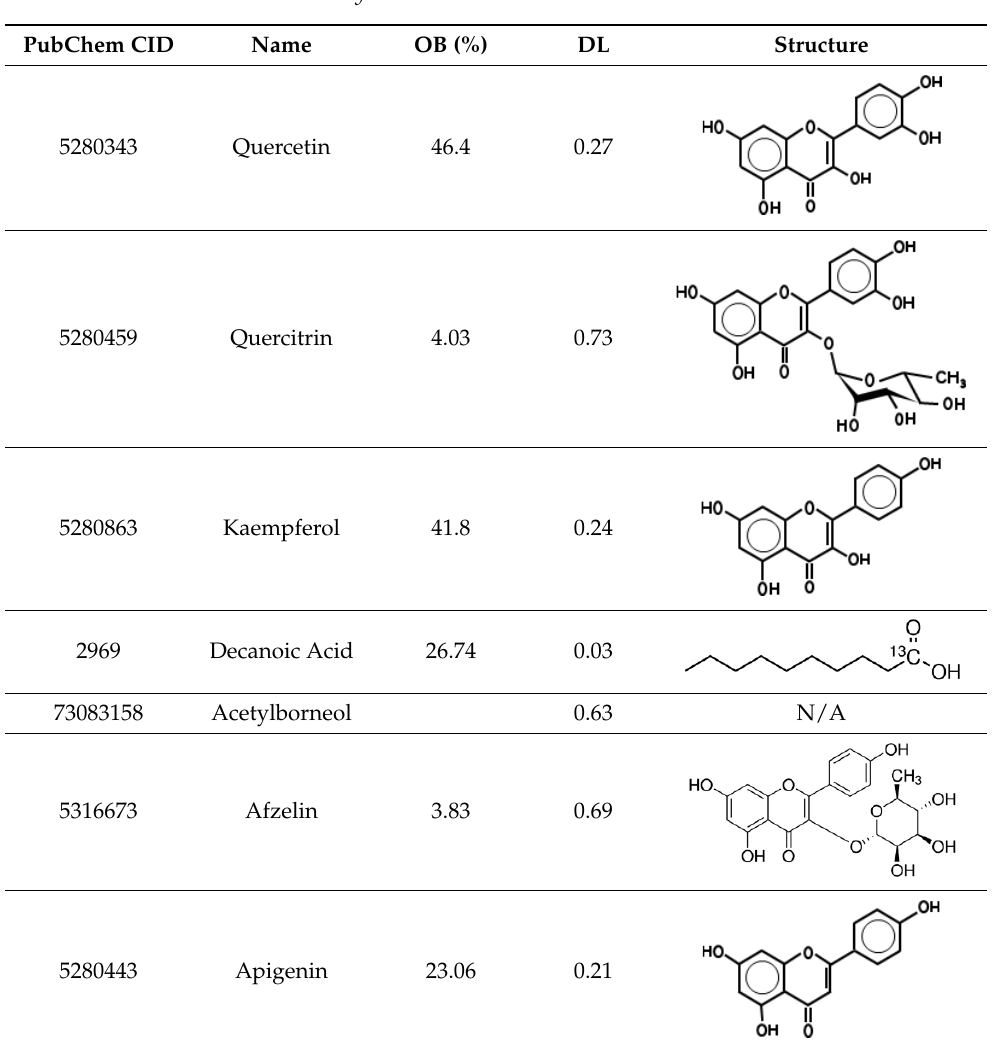
Table 1. Core metabolites of Houttuynia cordata.